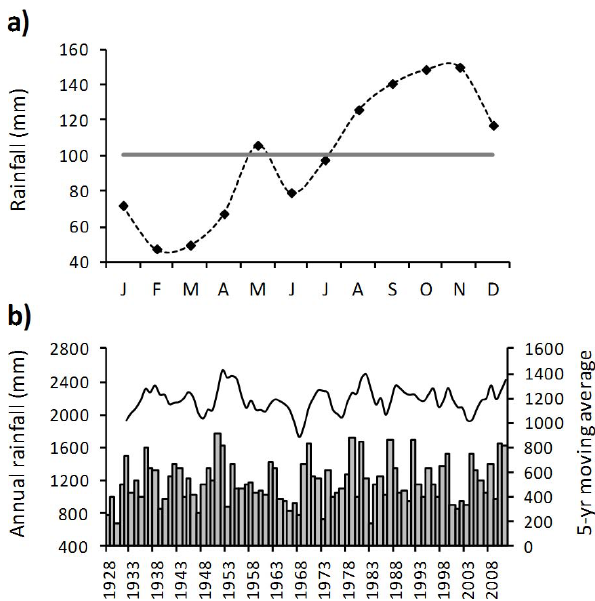
Fig. 2. (a) Mean monthly rainfall derived from national data, 1928– 2011. Solid grey line represents average of monthly mean values. (b) National annual rainfall totals, 1929–2011 (grey bars) and 5yr moving average (black line). Data courtesy of